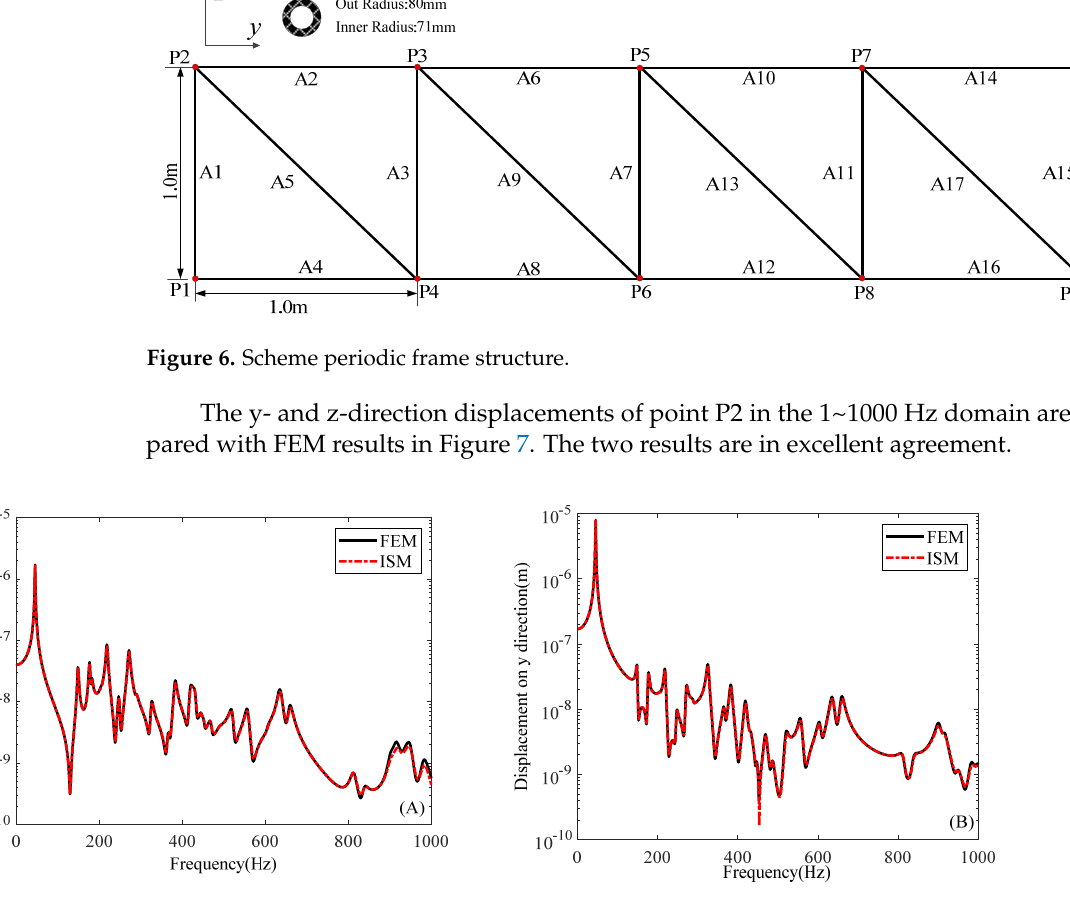
Figure 5. Force comparison of ISM and FEM of point P2 on the Z direction.